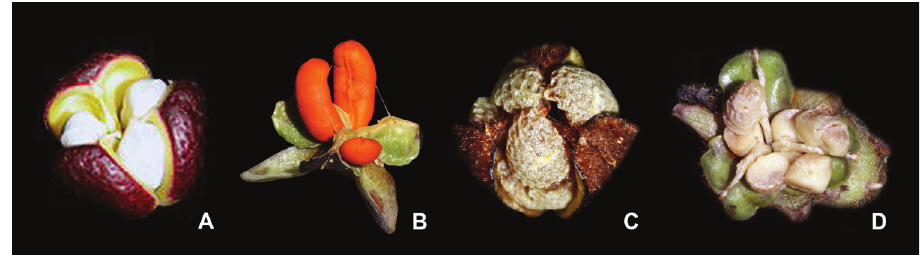
Figure 5. Aril morphology in Dichorisandrinae s.s . A – B Dichorisandra J.C.Mikan: A D. thyrsiflora J.C.Mikan B D. hexandra (Aubl.) C.B.Clarke. C – D Siderasis Raf. emend. M.Pell. & Faden: C S. fuscata (Lodd.) H.E.Moore D S. albofasciata M.Pell. Photographs by M.O.O.